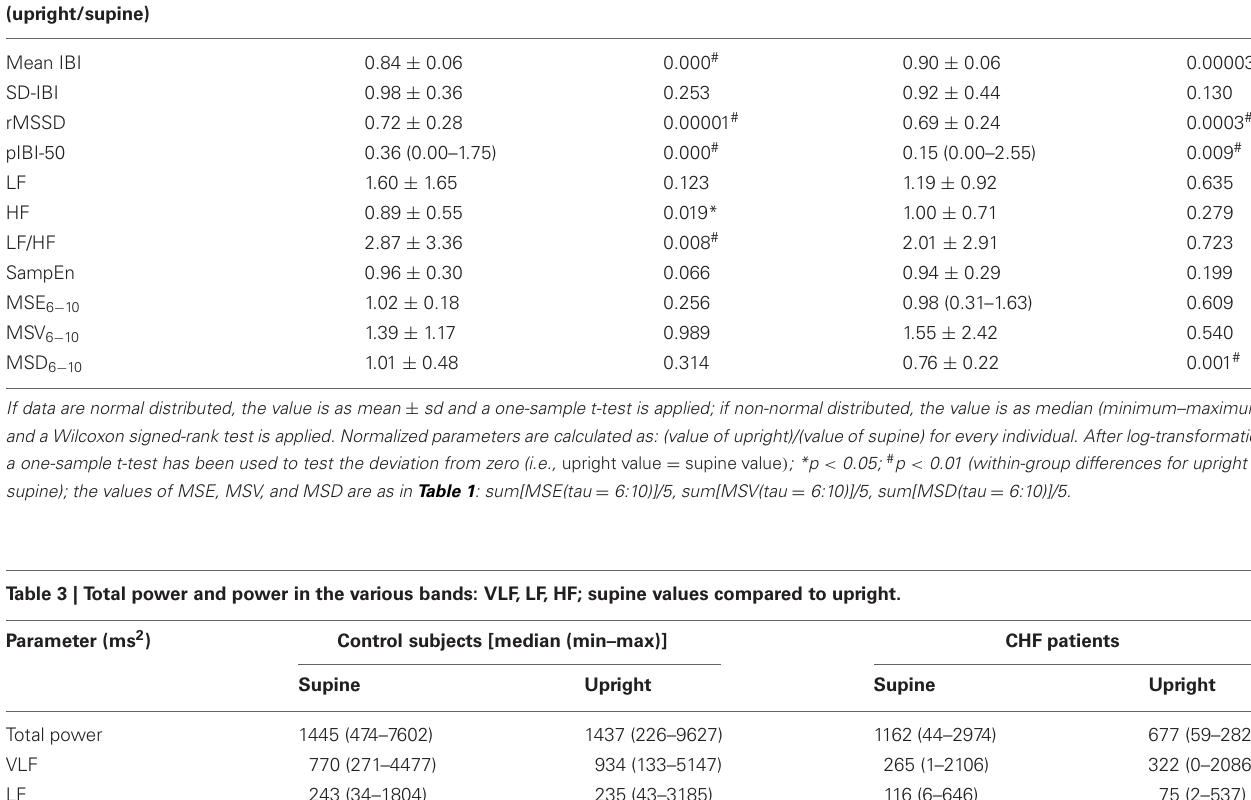
Table 2 | Control subjects and CHF patients: normalized parameters ( = upright/supine). Normalized Parameter =